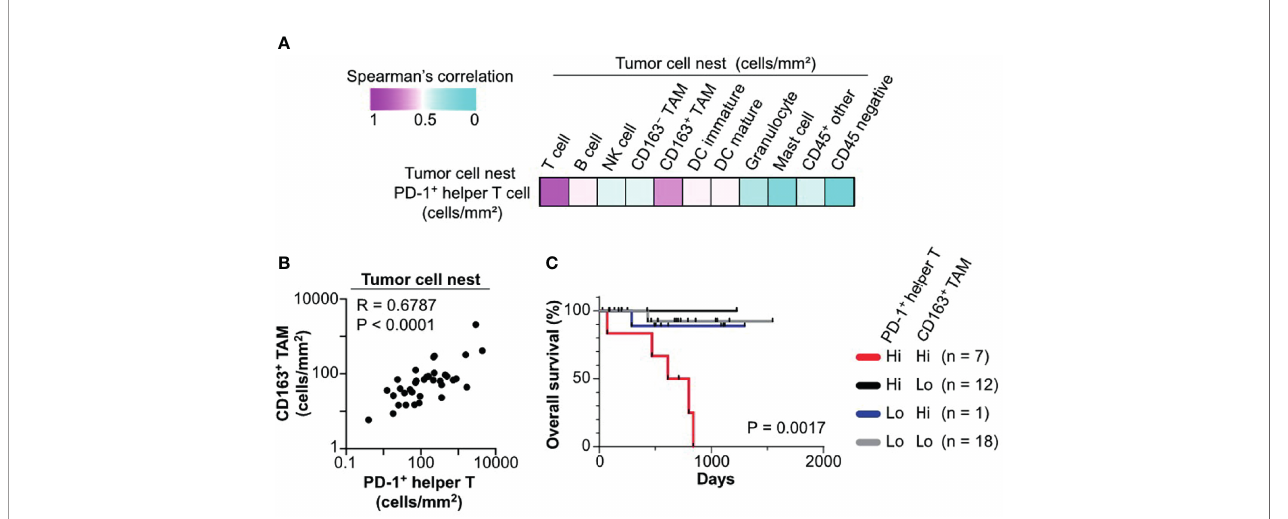
FIGURE 5 | Colocalization of PD-1 + helper T cells with CD163 + TAM is associated with poor prognosis. (A) A heat map according to color scale (upper left) presents spearman correlations of cell densities of PD-1 + helper T cells versus various cell lineages within tumor cell nests. (B) Spearman correlation coef fi cient shows a correlation between PD-1 + helper T cells and CD163 + tumor associated macrophages (TAM) in tumor cell nest regions. The X and Y axes are shown on a logarithmic scale. (C) Kaplan – Meier analysis of overall survival strati fi ed by cell densities of PD1 + helper T cell (cutoff = mean) and CD163 + TAM (cutoff = median) in tumor cell nests. Statistical signi fi cance was determined using the log-rank